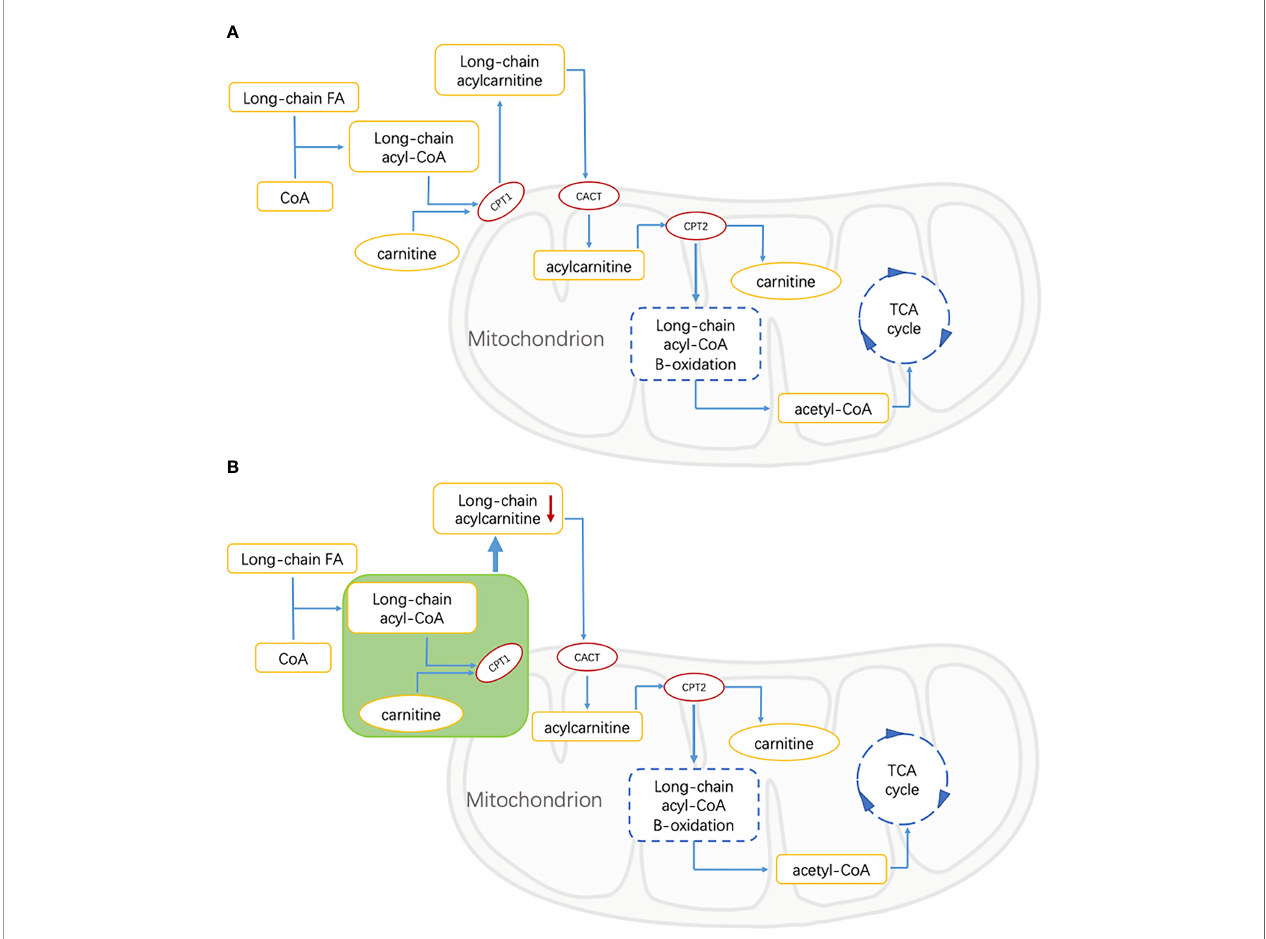
FIGURE 3 | FA, fatty acid; CoA, Coenzyme A; CPT1, carnitine palmitoyltransferase 1; CACT, carnitine acylcarnitine translocase; CPT2, carnitine palmitoyltransferase 2; TCA, tricarboxylic acid. (A) Energy supply pathways of long-chain fatty acids in healthy people. Long-chain fatty acids are catalyzed by CPT1, CPT2, and CACT to produce acetyl-CoA, which is involved in the tricarboxylic acid cycle, and acylcarnitine is the intermediate metabolite. (B) Energy supply pathway of long-chain fatty acids in patients with diabetic retinopathy. The green part shows the inhibition of free FAs transport of CPT1-mediated that resulted in the decrease of long-chain